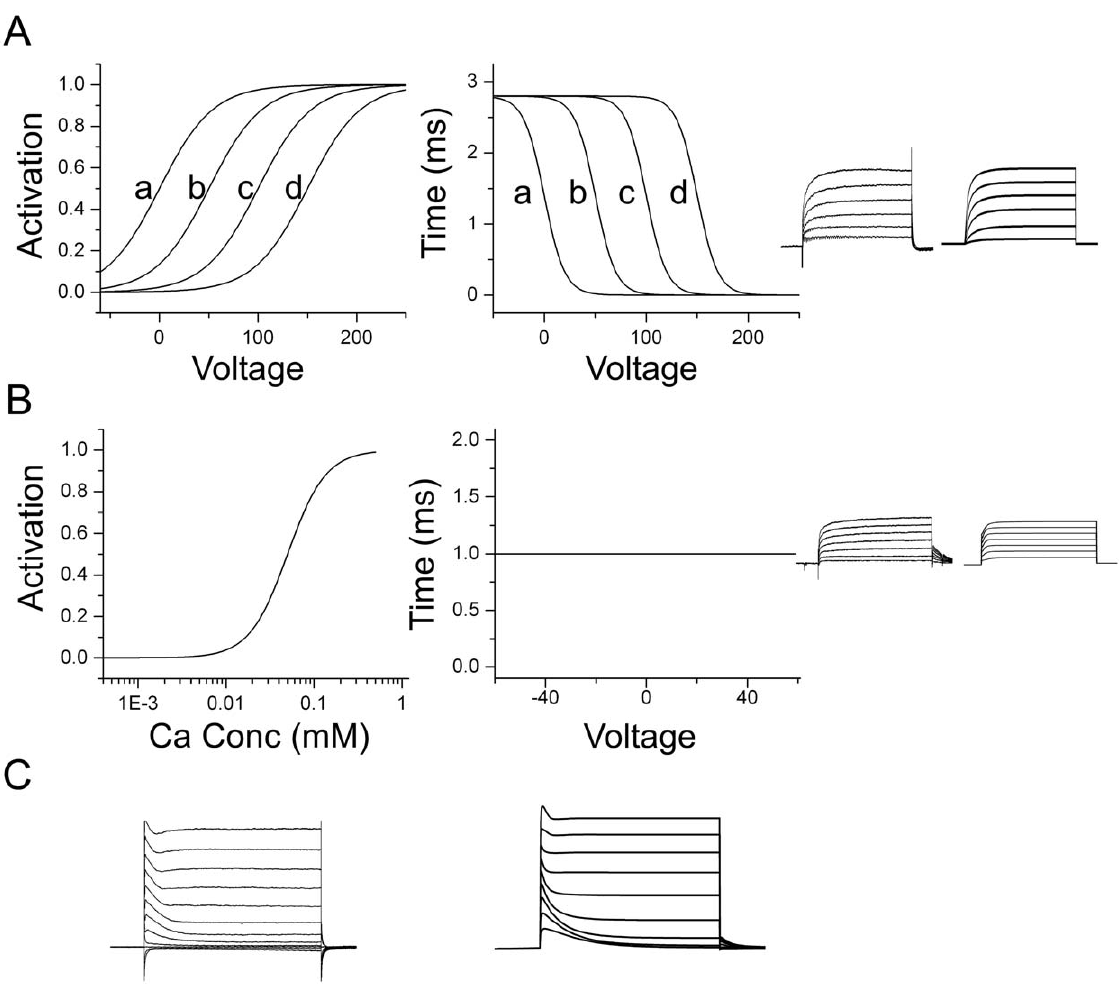
Figure 10. Modeling of BK and SK currents in SN DA neurons. (A). Model of the BK current in SN DA neurons. Left Panel. Activation functions were obtained as in figure 9F, shown here for clarity. Activation function and time constant of the BK currents fit to the rising phase of the experimental currents were fit using eqs. (1) and (2) with t a ~ 20 ms, t b ~ 2 ms and V BK and K BK as defined in figure 9F. Right Panel. BK currents generated using the MATHEMATICA NDSolve function. The calcium concentration was solved in parallel for this currents using a procedure similar to the one described in figure 11. (B) Model of the SK current in SN DA neurons . Left Panel. Activation function estimated from the fit to experimental currents using Eq.(4), where K SK =0.01 mM. Middle panel. Time constant of activation for SK currents were directly derived from the fit to the experimental currents. This time constant is voltage-independent consistent with the voltage-independent activation postulated for this current. t S K ~ 1 ms. Right Panel. SK currents generated using a MATHEMATICA protocol similar to the one described in figure 11. (C) Left panel. Currents obtained from a P4 neuron in response to depolarizing voltage pulses (Same as in figure 3A, left). TTX used to block Na z channels. Right panel. Model neuron incorporating the I A , BK , and SK currents in response to depolarizing voltage pulses. No attempt made at fitting exactly the curves and this panel shows in a qualitative sense how the model approximates a typical outward current recording from a SN DA neuron. the geometry to a point (x,y,z). We have integrated over the shells and used Gauss theorem to simplify the diffusion equation. The results of the integration give